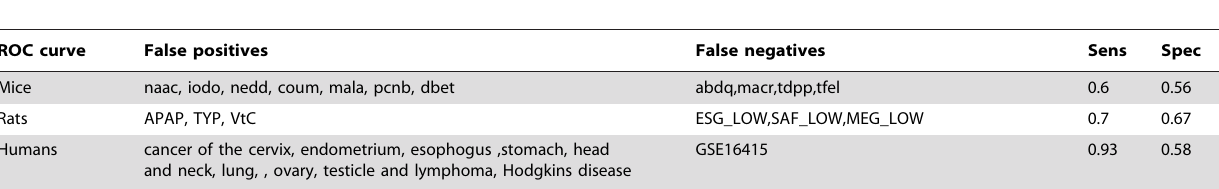
Table 4. False positives and false negatives predictions of predictors across the three species at appropriately chosen points on the receiver-operator curves in Figure 1.